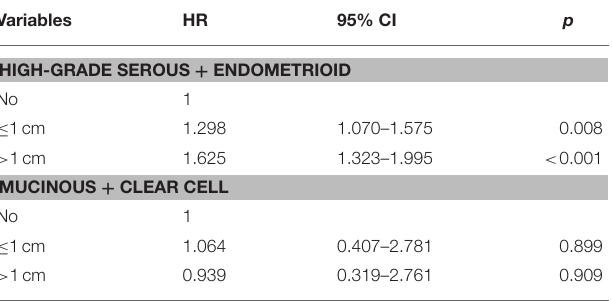
TABLE 3 | Multivariate prognostic analyses of the effect of residual tumor size on outcomes by the specificity of histological subtypes.